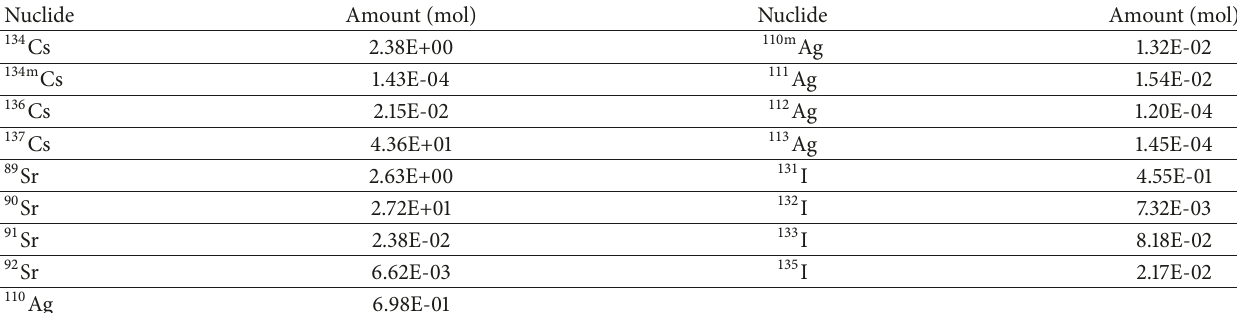
Table 6: Amounts of important FPs in the equilibrium